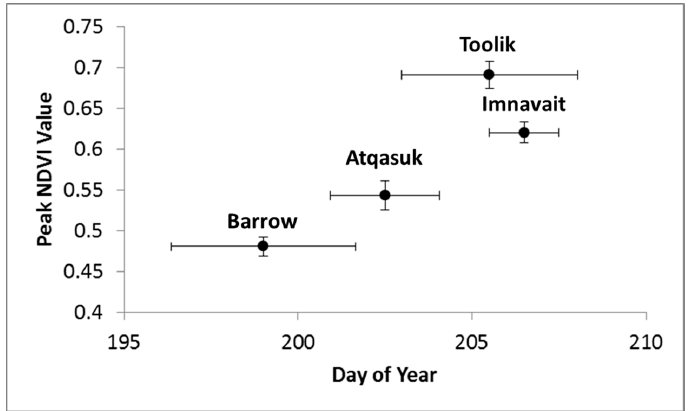
Figure 3. Five-year averages of peak NDVI values and corresponding days of year for the four MISP transects. Error bars denote the standard deviation of the mean for peak NDVI value and day of year. A comparison of June NDVI trends, averaged for full transects, showed differences between the rates of change across the four MISP sites (Figure 4). The southernmost sites, Toolik Lake and Imnavait Creek, had faster average rates of increase (+0.0132 and +0.0104 NDVI day − 1 , respectively, p < 0.0001) compared to the northernmost sites, Barrow and Atqasuk (+0.0031 and +0.0061 NDVI temperature of <5 °C, with all four transects having NDVI change rates that were below average. For